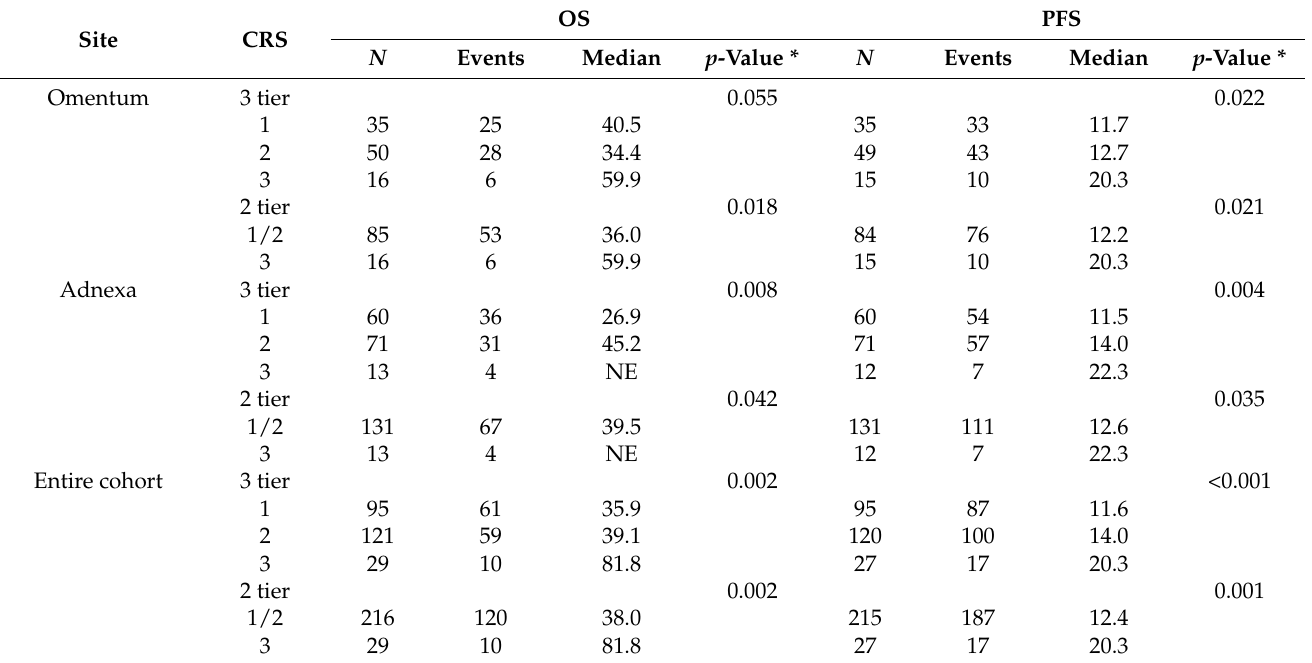
Table 2. Survival analysis by CRS for each scored tissue sample site and the entire